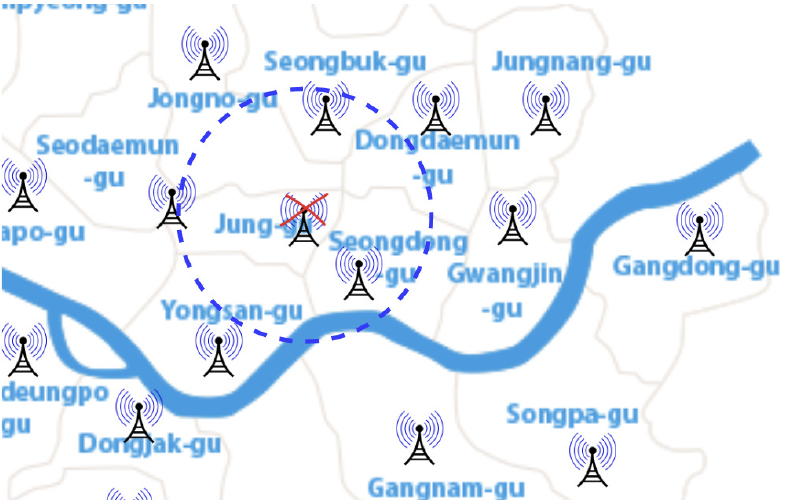
Figure 8. Malfunction Monitoring Station and Election of Monitoring Station for Cooperative